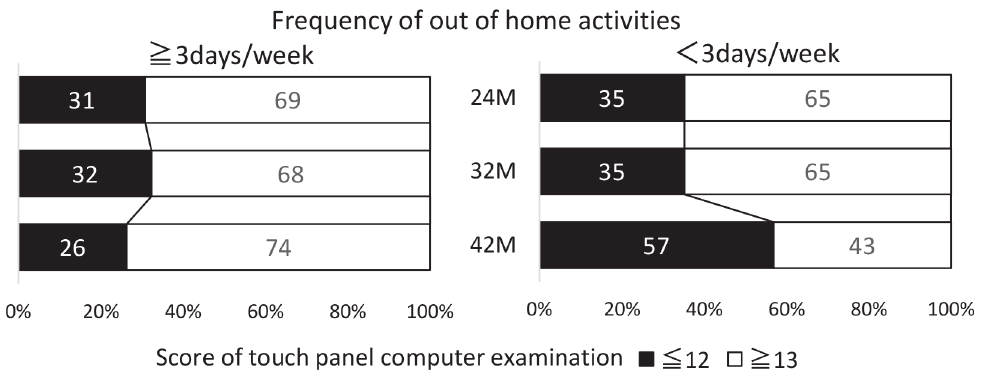
Fig 3. Changes in the ratio of people with normal cognitive function and those with declined cognitive function according to differences in the frequency of “ out-of-home activities ” . White and black columns indicate the ratio of people with normal cognitive function (touch panel computer exam score of (cid:1) 13) and declined cognitive function (exam score of (cid:3) 12), respectively. Right and left panels indicate the results of the people with the frequency of “ out-of-home activities ” of (cid:1) 3 day/week and < 3 day/week,